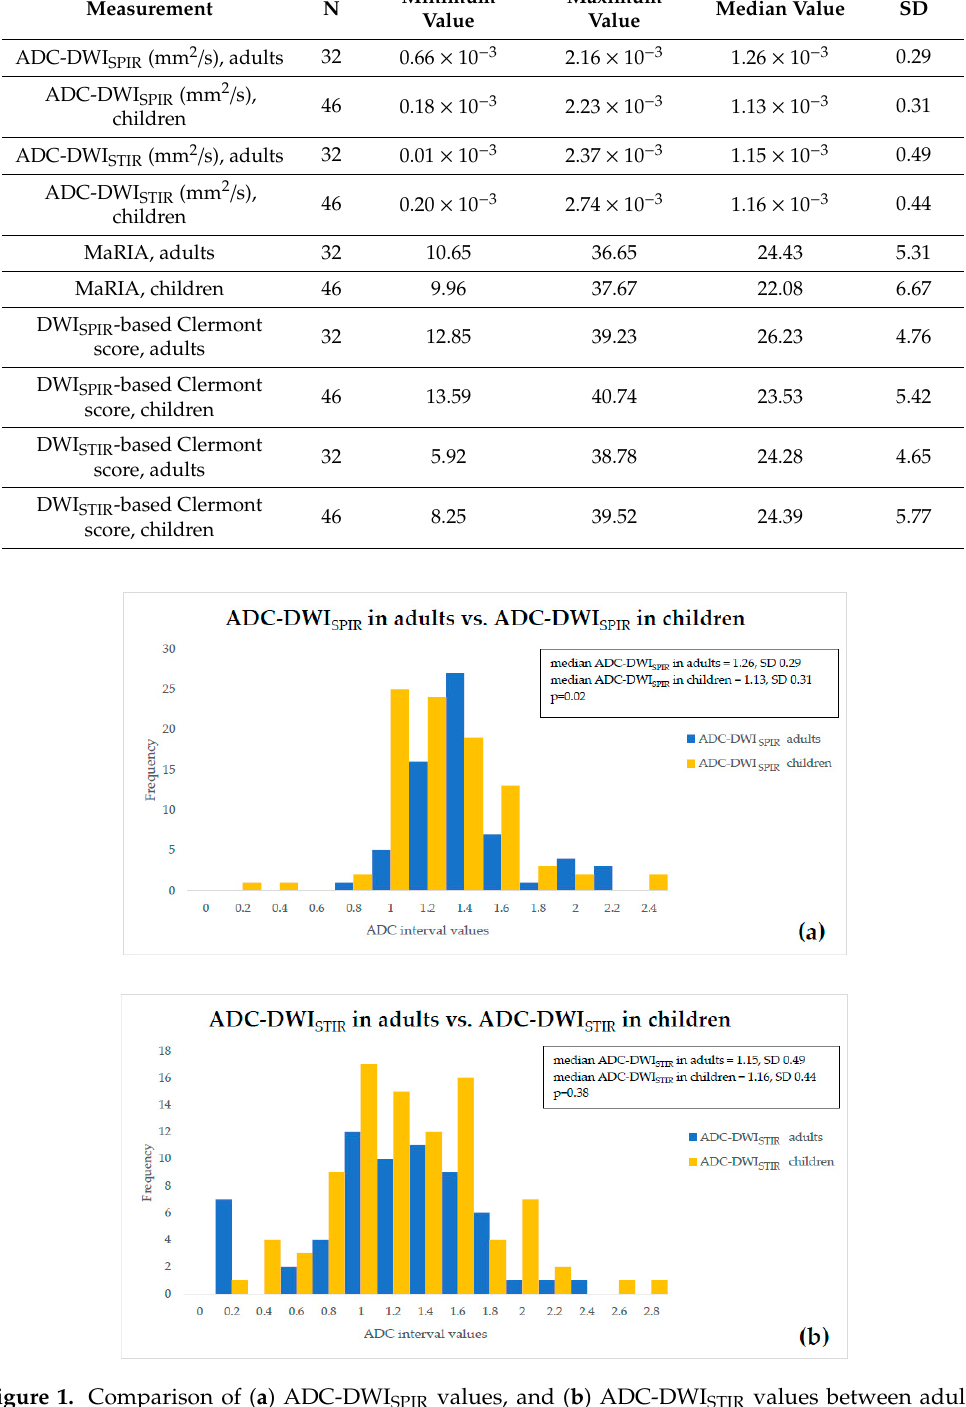
Figure 1. Comparison of ( a ) ADC-DWI SPIR values, and ( b ) ADC-DWI STIR values between adults and children.